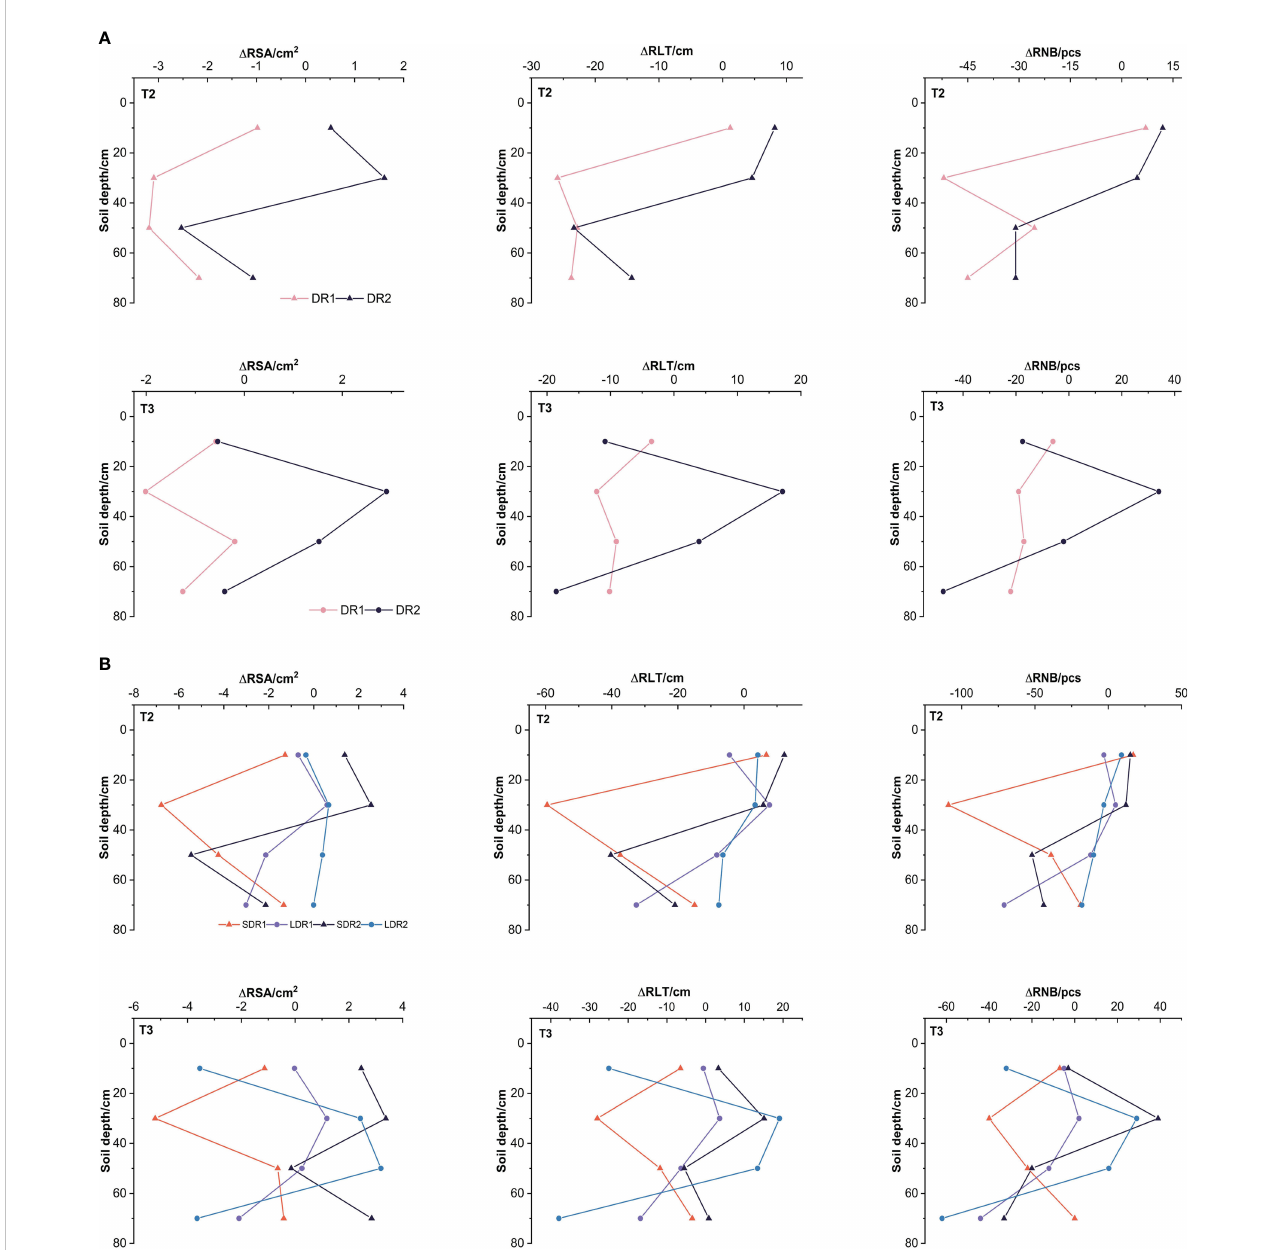
FIGURE 4 Effects of different (A) drought degree and (B) drought duration in the T2-T3 period on root growth indexes of summer maize. RSA, root surface area; RNB, root apex number; RLT, root